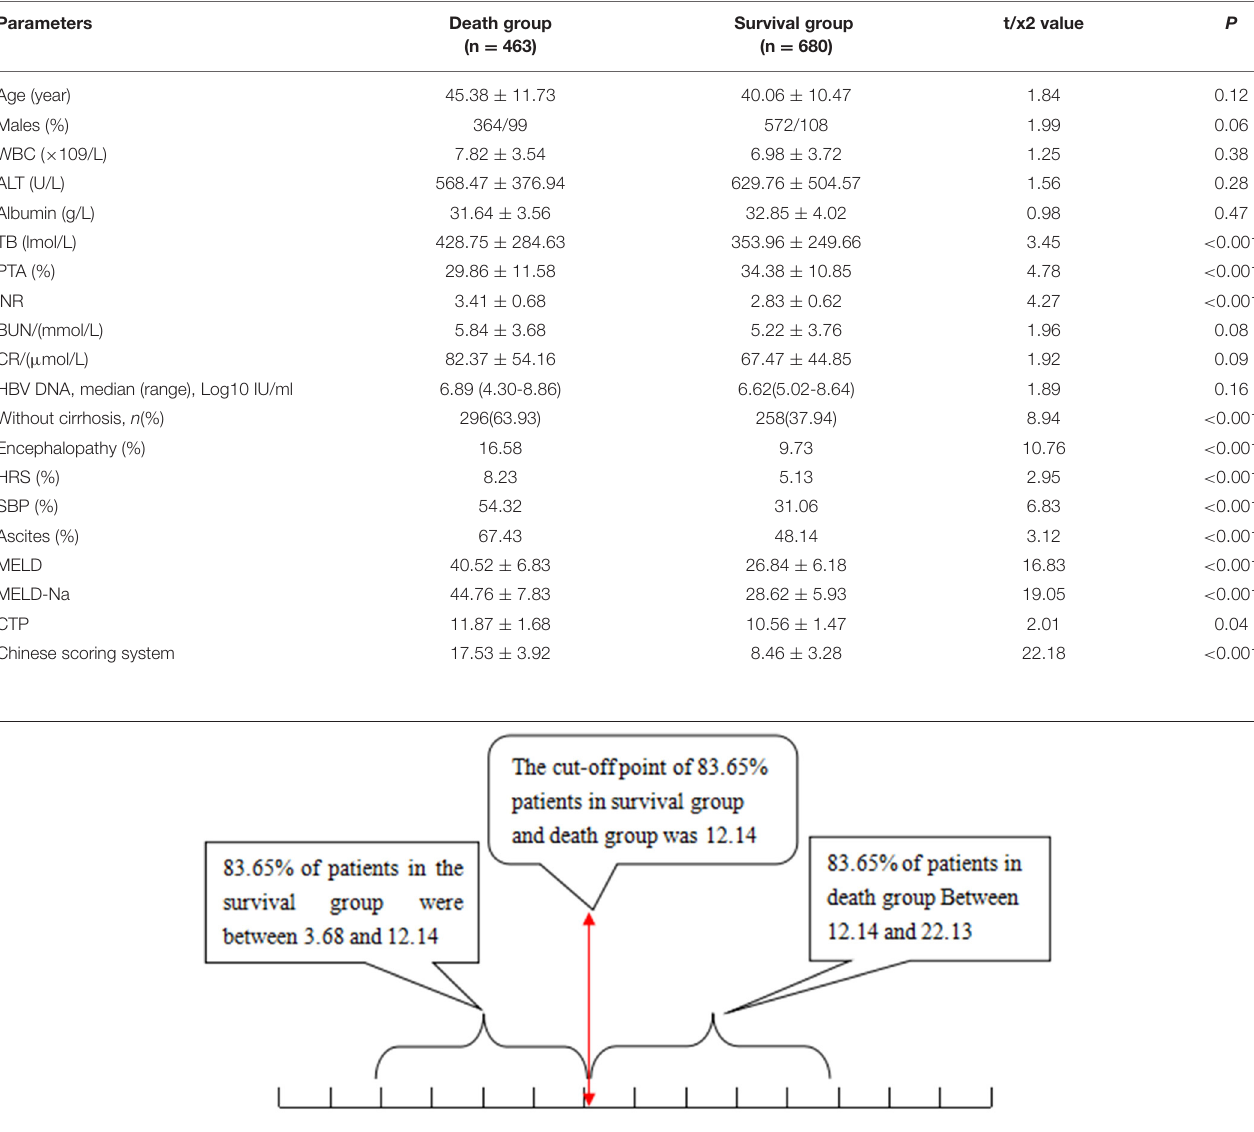
The ROC curve was plotted using the total scores. The area under the ROC curve for the Chinese scoring system was 0.954 (95% CI: 0.943–0.971) and the standard error was 0.013, with P < 0.001, suggesting good prediction performance. The area under the ROC curve for the MELD score was 0.896 (95% CI: 0.881–0.924),